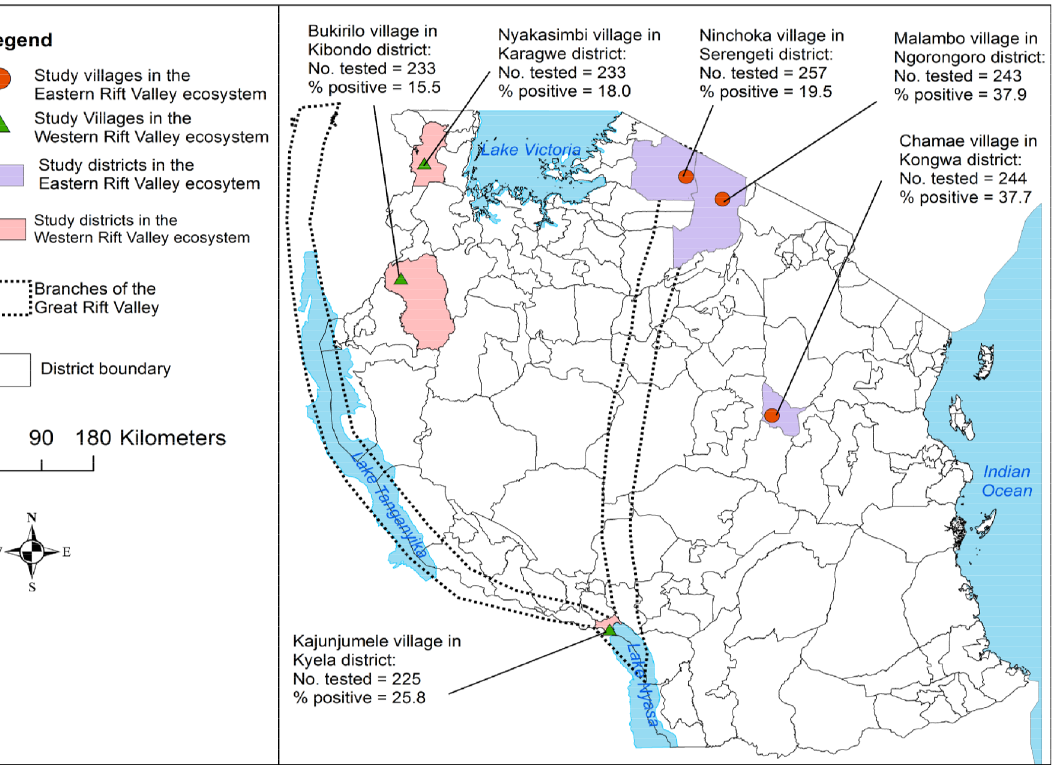
Fig 1. Map of Tanzania showing locations of study villages and districts. Overall, higher RVFV seropositivity was recorded in domestic ruminants from the villages located in the eastern than those in the western Rift Valley ecosystem.